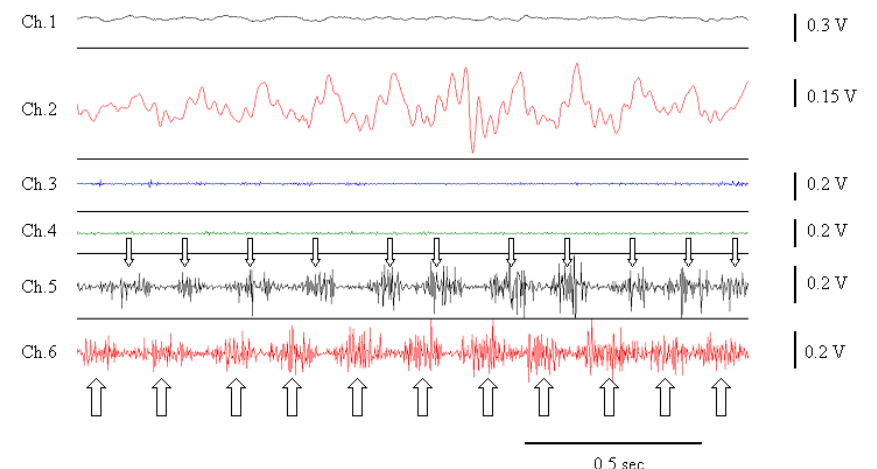
Figure 4. Recordings of action tremor in a neurological patient. Note the oscillations in channel 2 (accelerometry, right side; accelerometer fixed on the extremity of the index finger) and the alternating pattern of EMG bursts in channels 5 (Flexor carpi radialis, right side – small arrows) and 6 (Extensor carpi radialis, right side – large arrows). Channel 1, channel 3 and channel 4 correspond to accelerometry and EMG recordings on the left side.